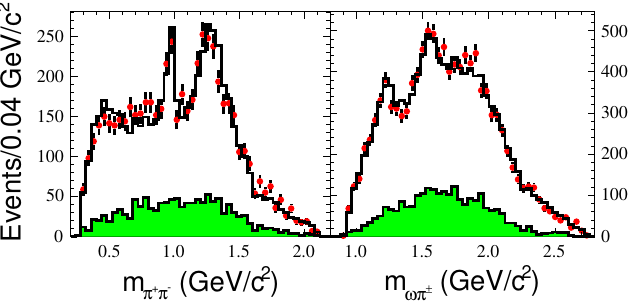
and m for group B data sets. π + π − ωπ ±